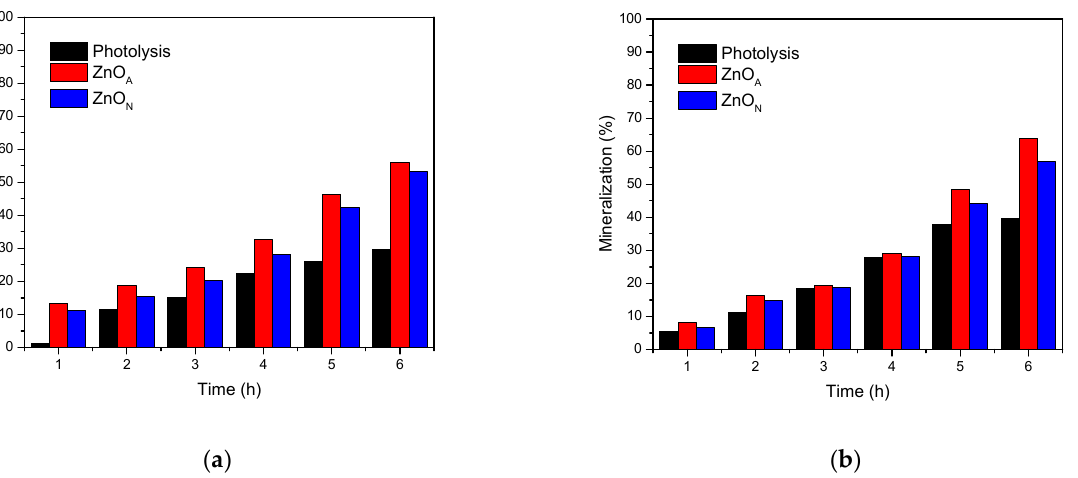
Figure 10. Comparison of the removal of Total Organic Carbon (TOC): 2,4-D ( a ) and 2,4-DCP ( b ).